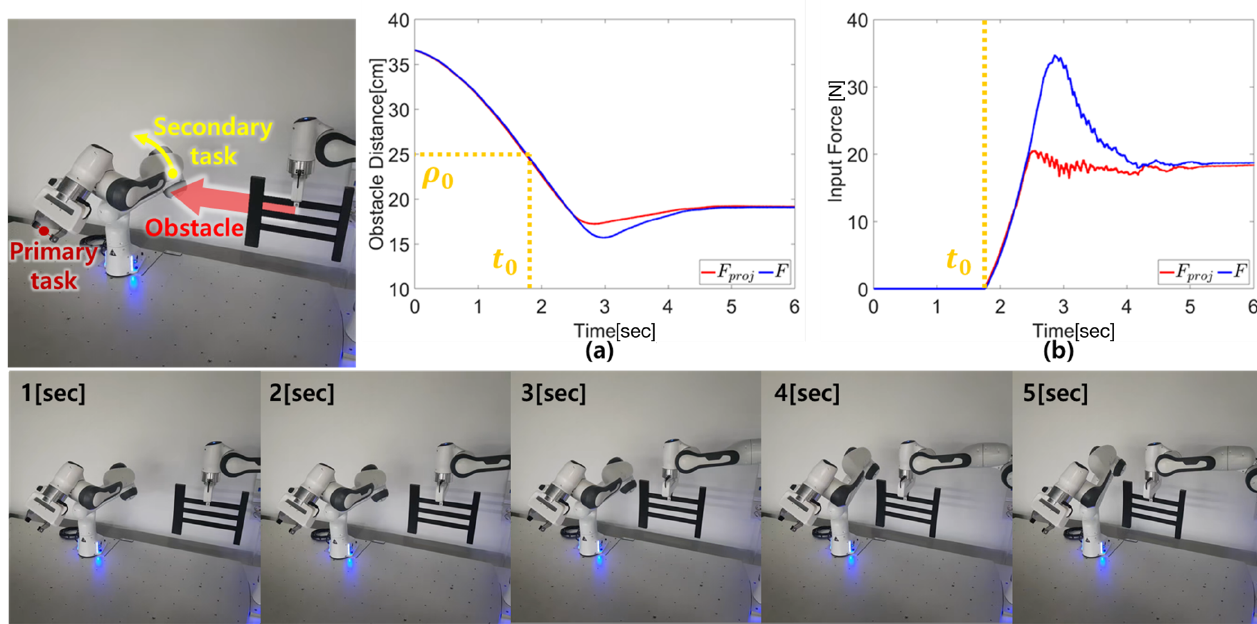
Figure 5. Experimental results for obstacle avoidance. The schematic of experiment is shown in the left. The primary task is the stationary task by utilizing 6 DoF at the end-effector and the secondary task is obstacle avoidance at link 4 (yellow point) while the obstacle approaches to link 4 from the right side of the manipulator at a speed of 5 cm/s. ( a ) shows the distance between the obstacle and the control point. ( b ) shows the input force when the obstacle approaches. ρ 0 is the distance of the obstacle that the manipulator begins to avoid. t 0 is the time when the obstacle infiltrates the radius ρ 0 . The proposed method avoids the obstacle faster with the less force